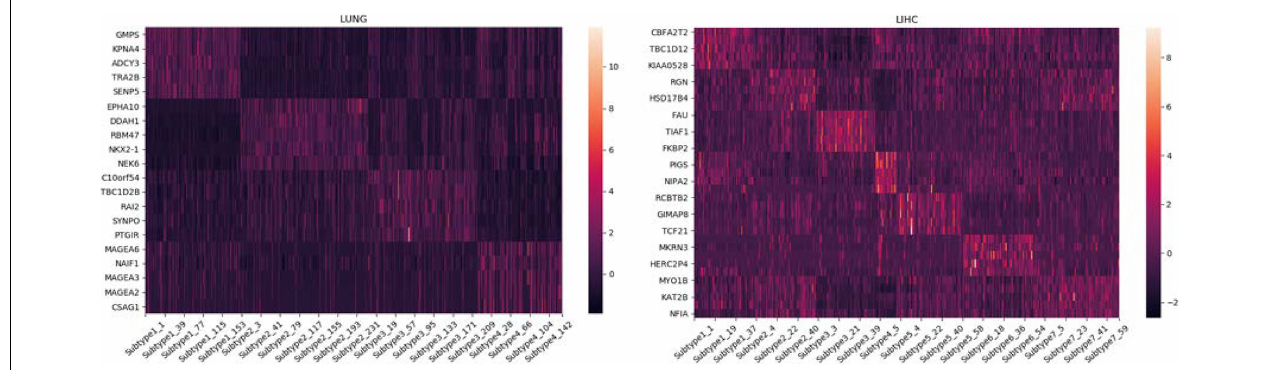
FIGURE 3 | Differential expression of some essential genes in different subtypes on LUNG and LIHC.